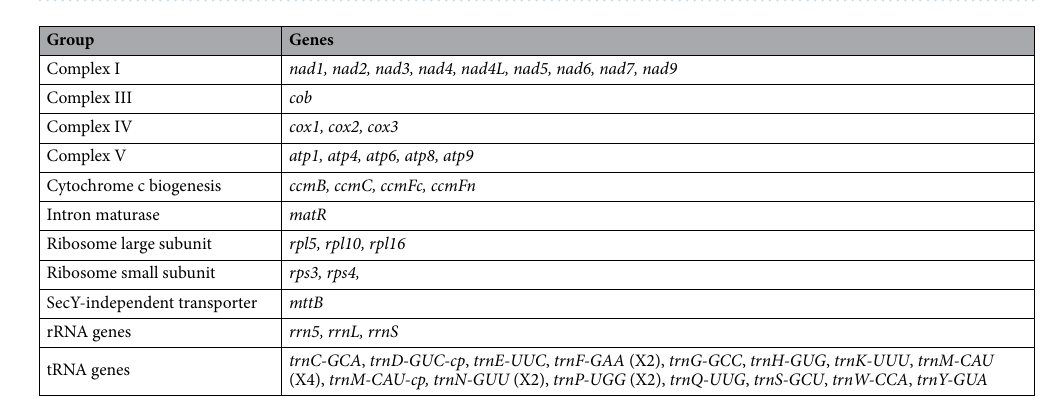
Figure 1. The circular mitochondrial genome of G. mangostana variety Mesta. Genes inside the circle are transcribed clockwise while genes outside the circle are transcribed anti-clockwise. The gray bars inside the circle represent the GC content of the sequence. Asterisks (*) indicate genes containing intron(s).